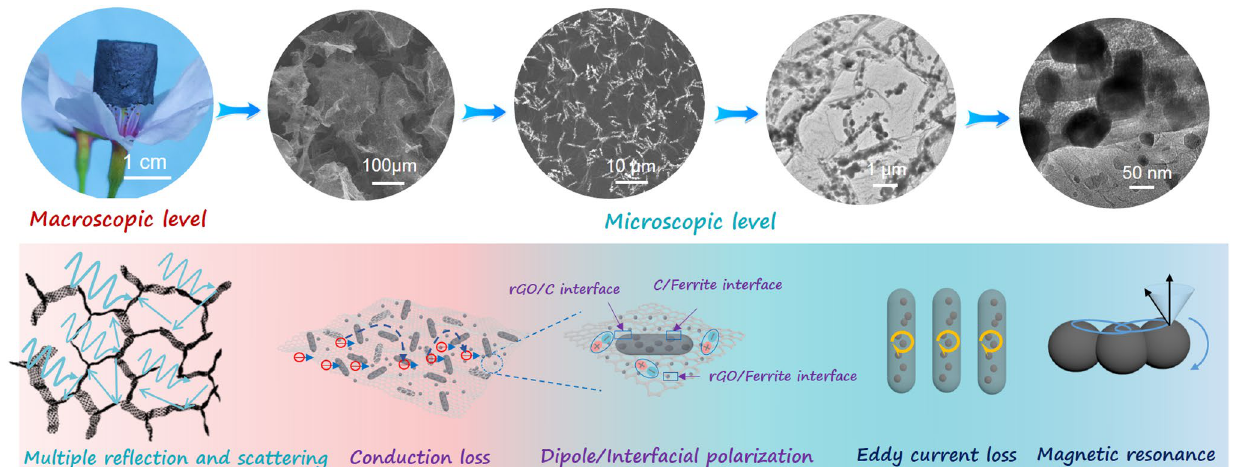
Fig. 9 Schematic of the associated microwave absorption mechanism of the proposed MOF/rGO-derived magnetic and dielectric